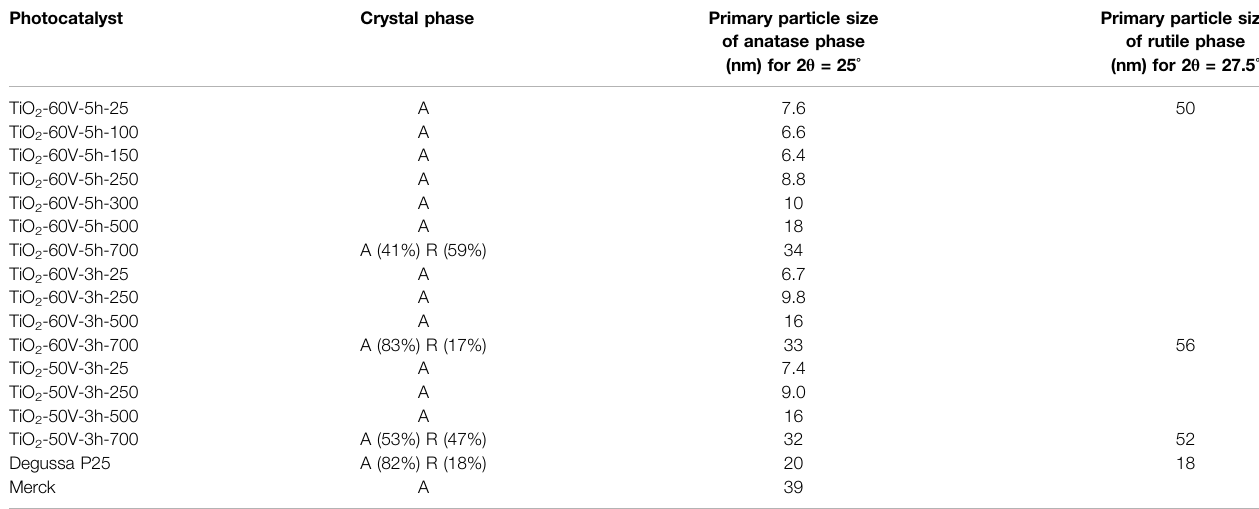
TABLE 1 | Crystal phases, phase percentages and primary particle sizes of photocatalysts. Photocatalyst Crystal